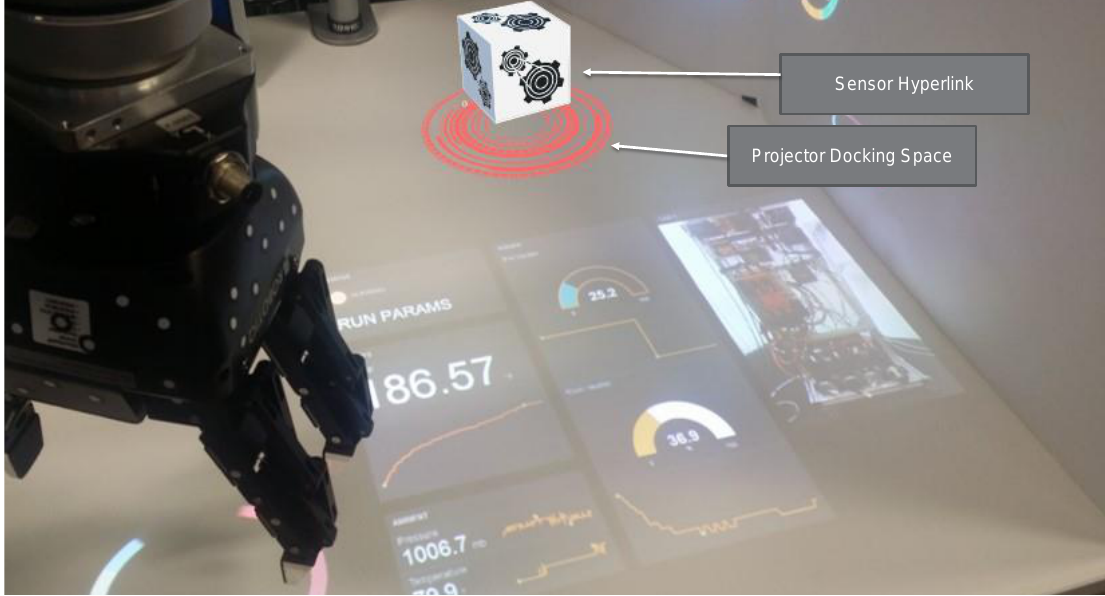
Figure 3. Representation of Hyperlinks in HoloLens (3D cubes) and projected surfaces (red